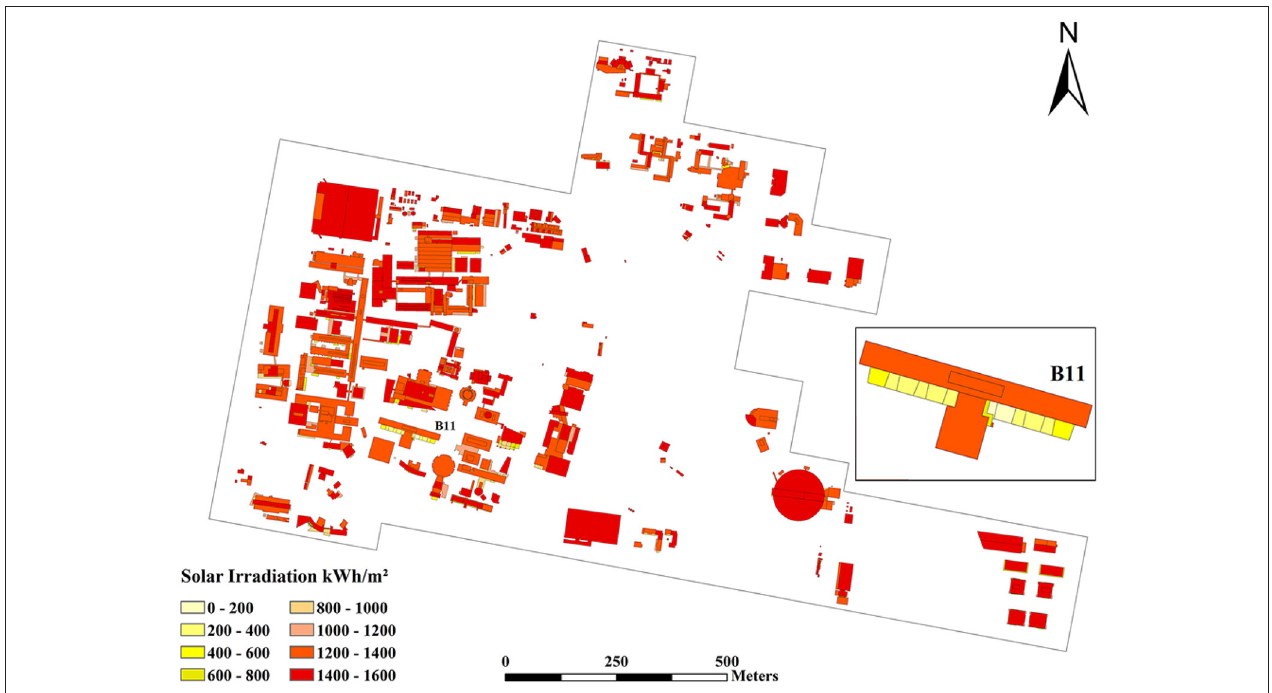
FIGURE 7 | Annual solar map based on rooftop polygons (Radosevic et al., 2020).